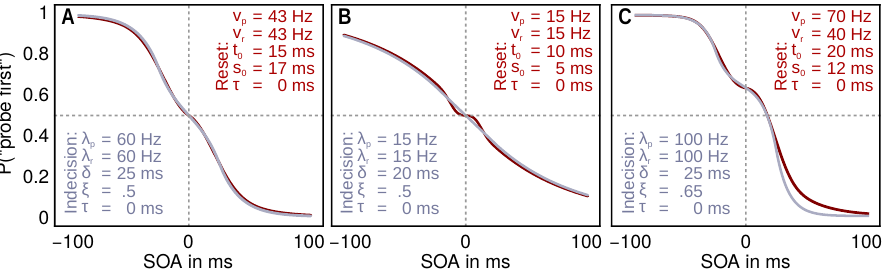
Figure 1. ( A ) for many cases, the two models predict similar “probe first” curves, though assuming different values for the rate parameters; ( B ) the encoding reset model can produce shallow overall curves with a crisp plateau. For the indecision range model , the dispersion of the plateau is always similar to that of the curve in general, producing no noticeable plateaus for shallow curves like this one; ( C ) the vertical plateau position can shift independently of the processing rate in the indecision range model . In this example, both rates are equal ( λ p = λ r ). By contrast, in the encoding reset model , a similar vertically shifted plateau can only be achieved by a difference in the processing rates ( v p > v r shifts the plateau upwards as in this example). Note that the weaker reference rate results in a more shallow curve at the positive stimulus onset asynchronies (SOA). An interactive demonstration can be found at